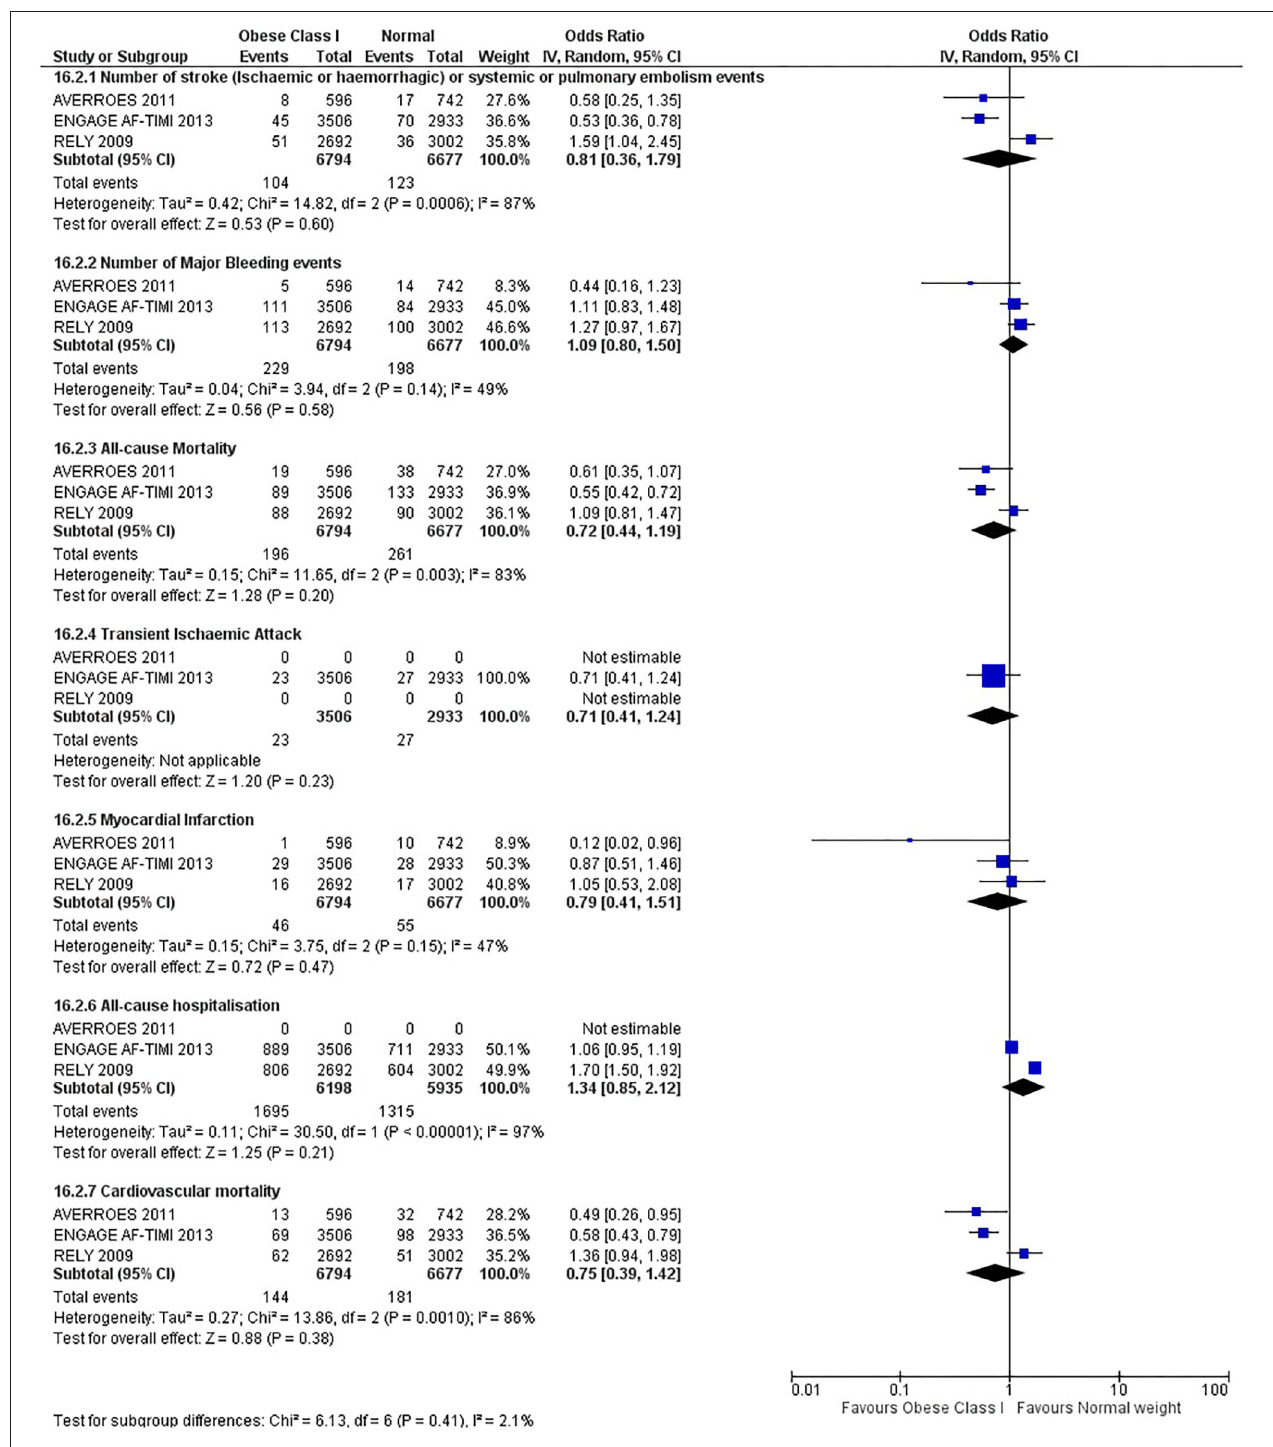
FIGURE 5 | Forest plot of comparison: Normal vs. Obese class I at 12